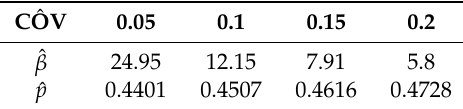
Table 1. Correspondence of ˆ β , ˆ p and C ˆOV.